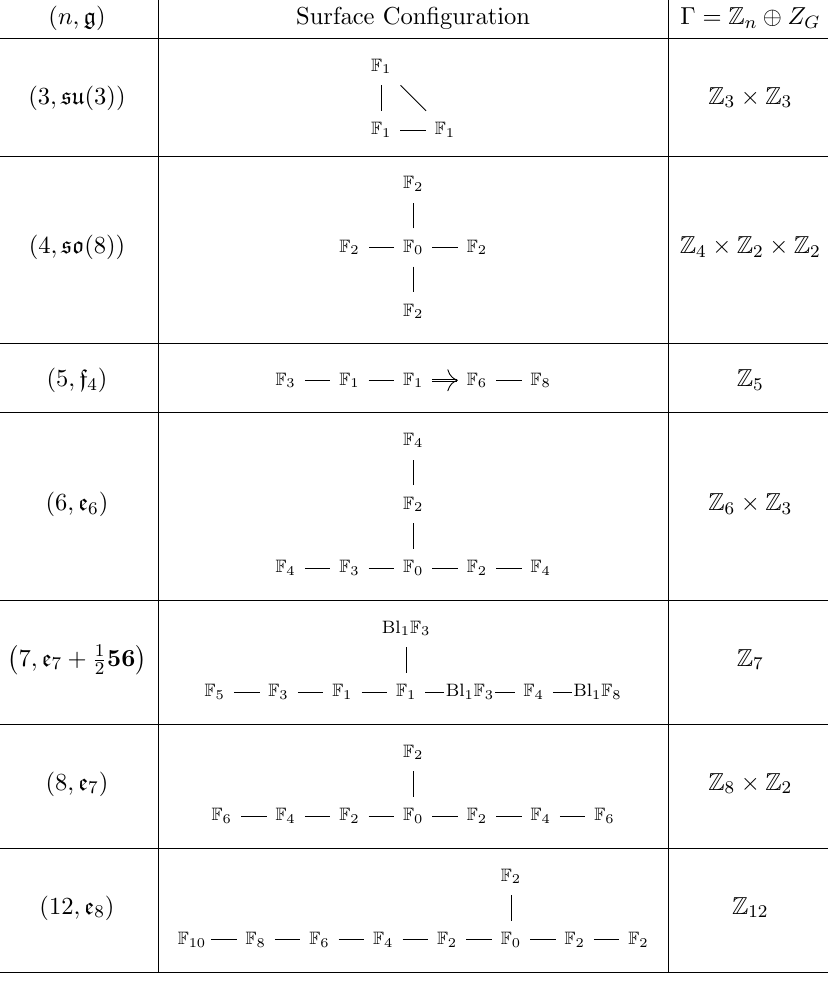
Table 4 . NHCs, surface con(cid:12)gurations and the 1-form symmetry computed from the intersection